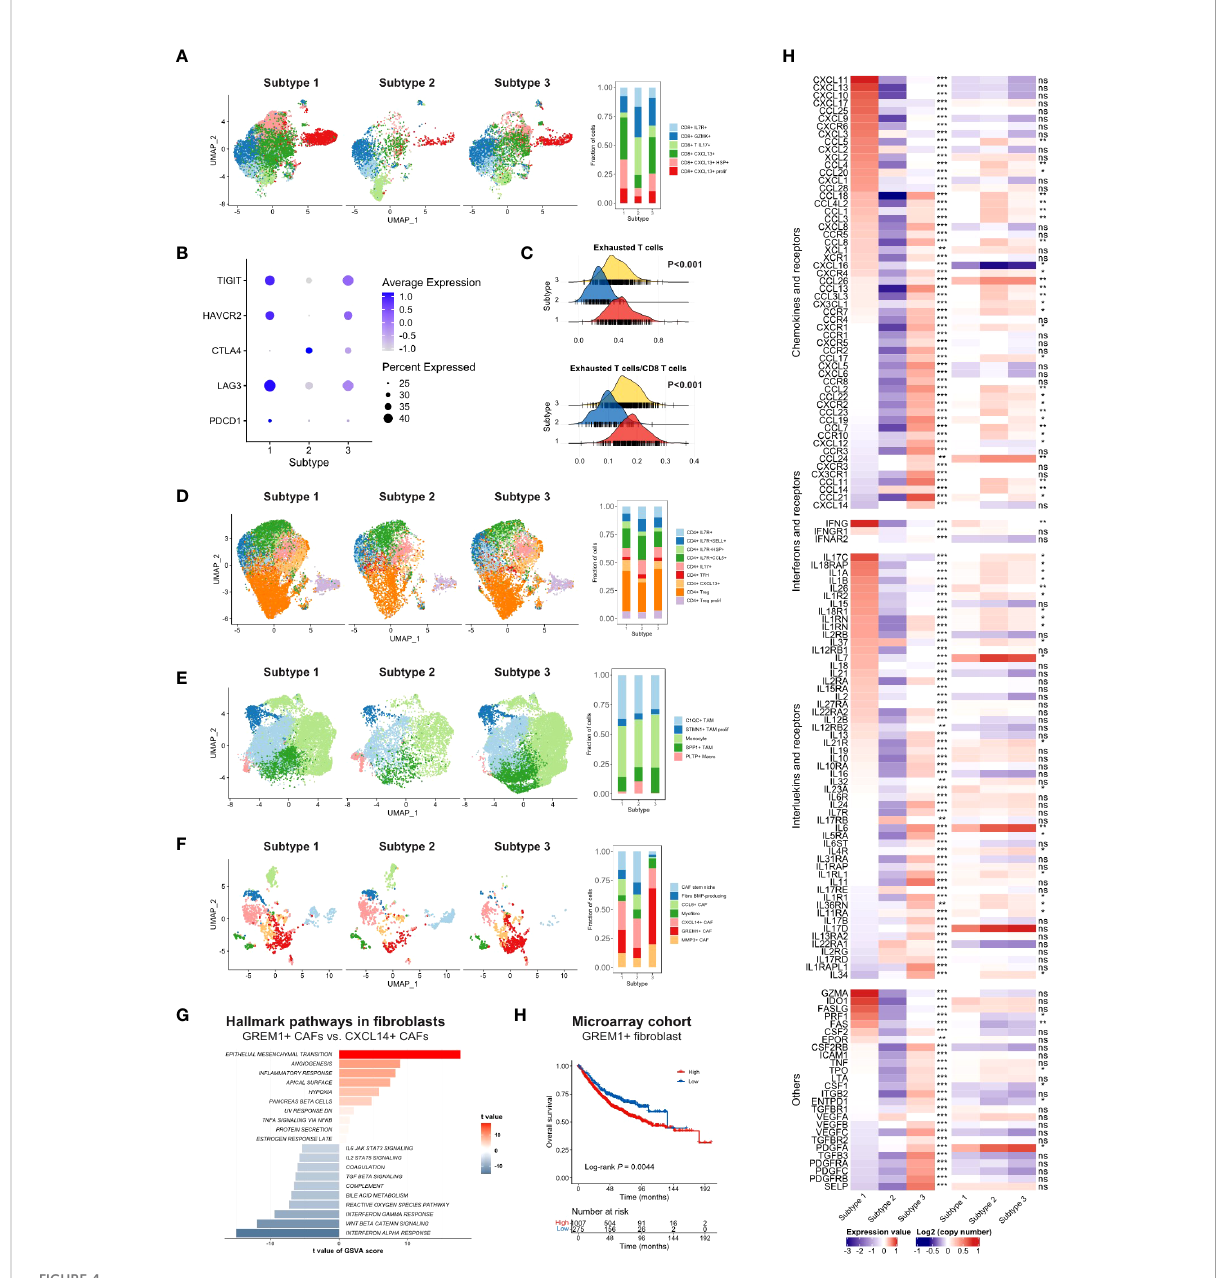
FIGURE 4 (A) UMAP of CD8 T cells in scRNA-seq cohort split by TMEC clusters (left) and the fraction of cell subsets in three clusters (right). (B) The average expression of exhaustion markers and expression percentage of CD8 T cells among three clusters. (C) The distribution of exhausted T cells in fi ltration and the ratio of exhausted T cells to CD8 T cells in fi ltration among each subtype. (D-F) UMAP of CD4 T cells (D) , monocytes/ macrophages (E) , and fi broblasts (F) in the scRNA-seq cohort split by TMEC clusters (left) and the fraction of cell subsets in three clusters (right). (G) GSVA results of hallmark pathways between GREM1+ CAFs and CXCL14+ CAFs. (H) Kaplan-Meier analysis of GREM1+ CAFs in microarray cohort. (E) The relative expression levels to the median value and mean log2(copy number) value of chemokines, interleukins, other cytokines, and their receptors among three subtypes. ***P < 0.001; **0.001 < P < 0.01; *0.01 < P < 0.05; ns: P >